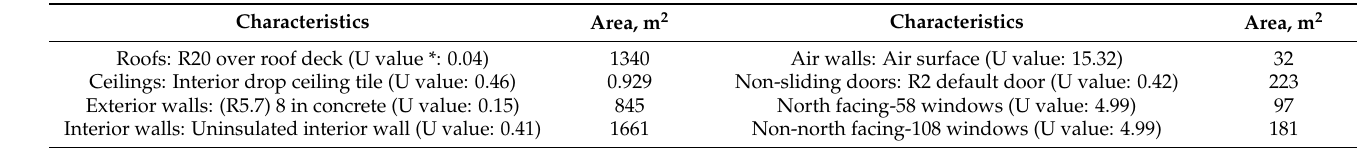
Table 2. Construction details for case study building.